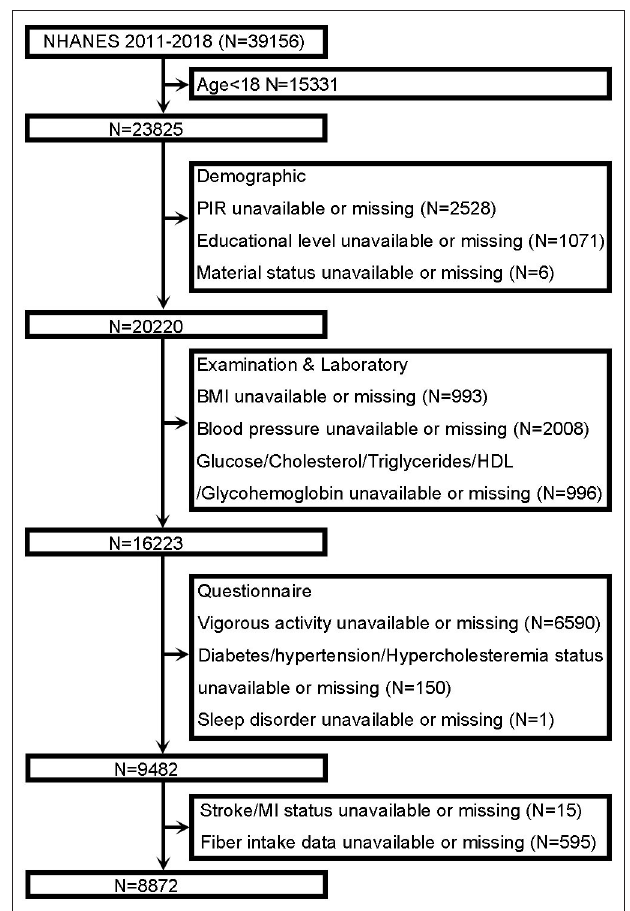
FIGURE 1 | Flowchart of the participant from the National Health and Nutrition Examination Survey (NHANES) 2011–2018. PIR, poverty to income ratio; BMI, body mass index; HDL, high-density lipoprotein; MI, myocardial